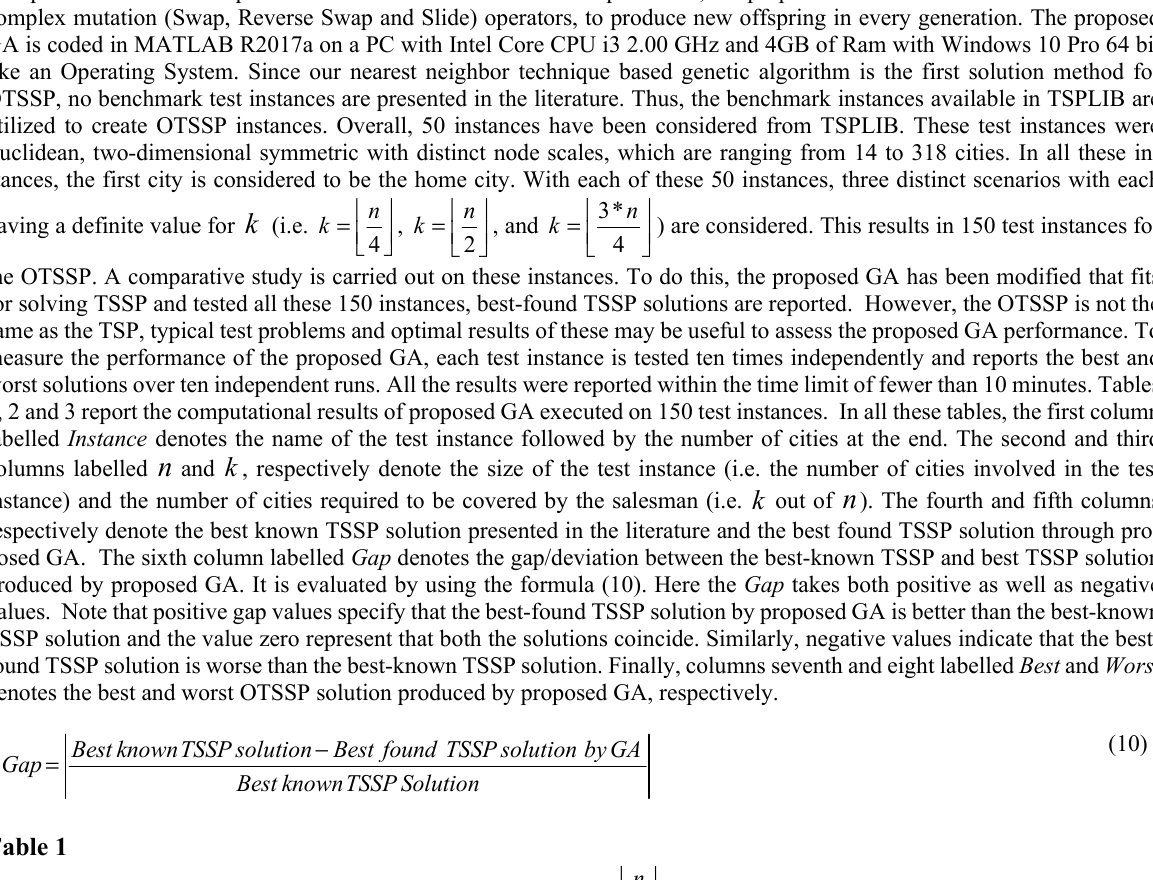
Computational results of proposed GA on instances